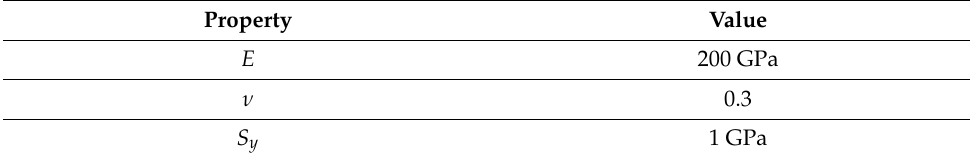
Table 3. Material properties for the reference surfaces.